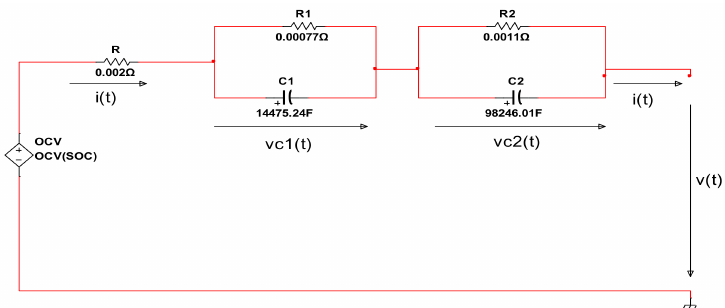
Figure 1. The second order 2RC Li-Ion battery EMC represented in National Instruments Multisim 14.1